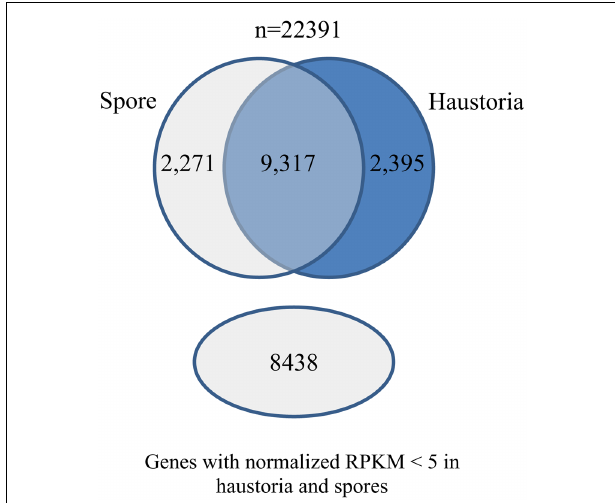
FIGURE 2 | Differential gene expression in Pgt germinated spores and haustoria. Venn diagram of predicted gene set showing the number of genes that had statistically significant changes in expression between germinated spores and haustoria (Baggerley’s test FDR corrected p -value < 0.05 and expression difference > 20RPKM), genes that did not show differential expression between the two tissues, and those that showed very low expression (RPKM < 5) in both